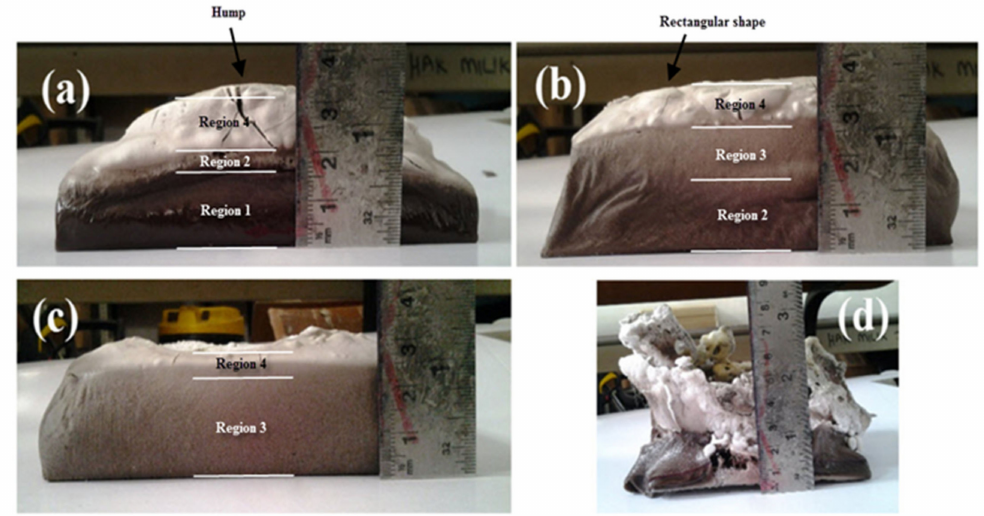
Figure 18. Color difference in binder layer of geopolymer sample ( a ) S5, ( b ) S7, ( c ) S23, and ( d ) S28.